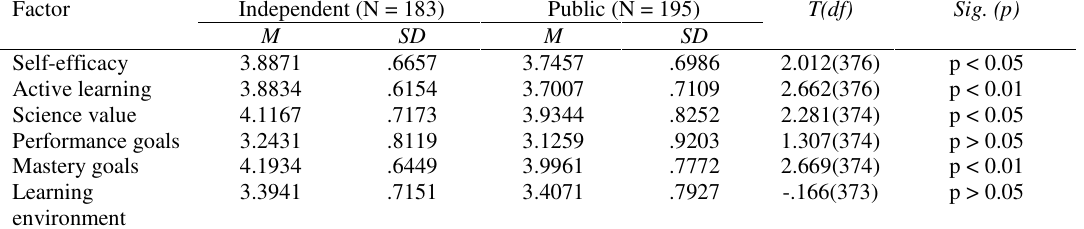
Table 3 Means, standard deviations and significance of differences between independent and public schools